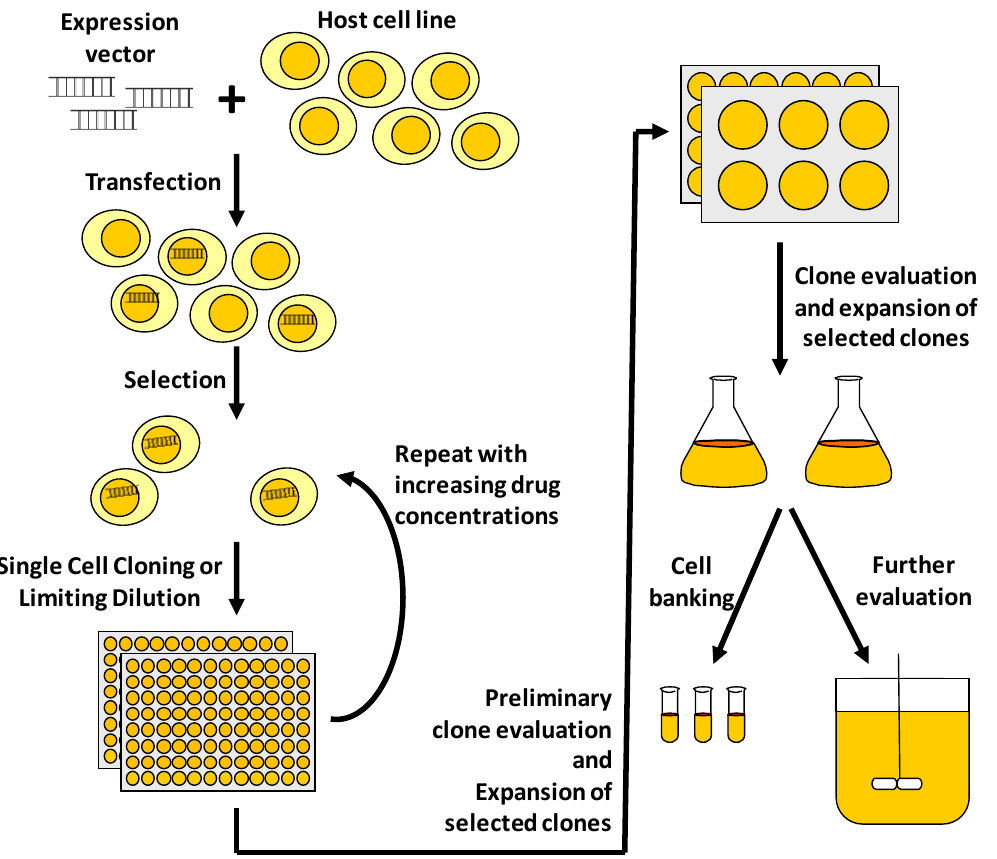
Figure 1. Illustration of a typical process to develop a mammalian cell line for recombinant protein manufacturing. After transfection of the host cell line with the expression vector containing the gene of interest (GOI) and selection marker, the cells undergo drug selection and cloning to derive cells that are producing the GOI. When gene amplification systems are used, concentrations of selection drug (e.g., MTX or MSX) can be increased step-wise to derive cell clones that are more productive. Cell clones with high recombinant protein titer are chosen for progressive expansions before cell banking and further clone evaluations, such as production stability of the cell clones and quality of recombinant